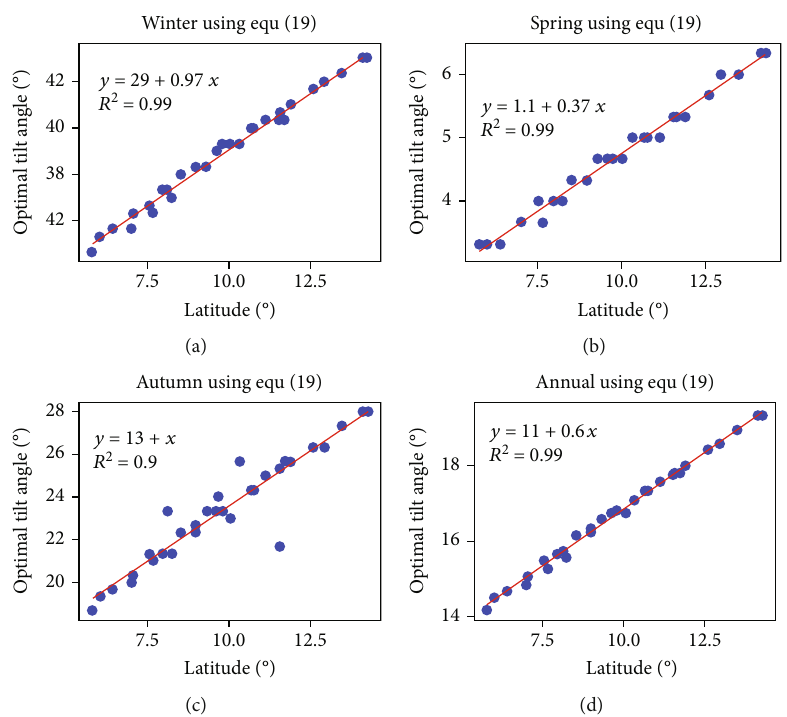
Figure 13: Regression model for seasonal and annual optimal tilt angle using Equation